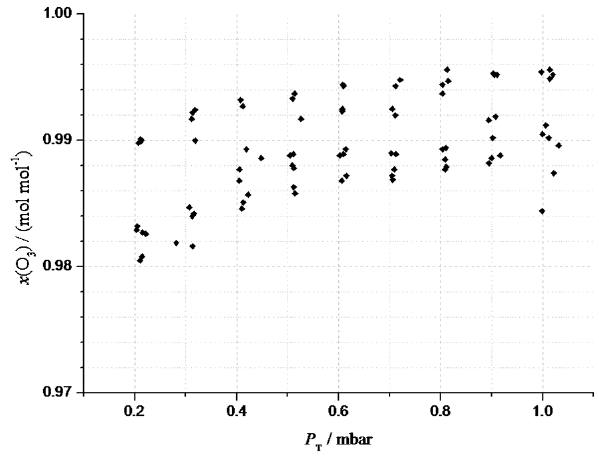
Figure 6. Ozone mole fractions x (O 3 ) in molmol − 1 calculated for all measurement points, plotted versus the sample pressure P T in